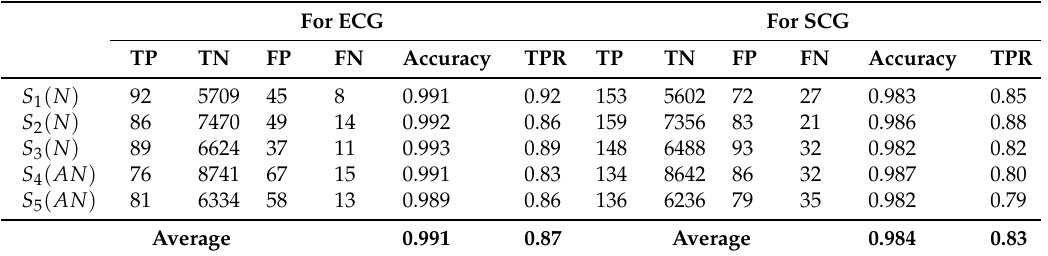
Table 6. Evaluation result of ECG and SCG important points selection algorithms. For ECG For